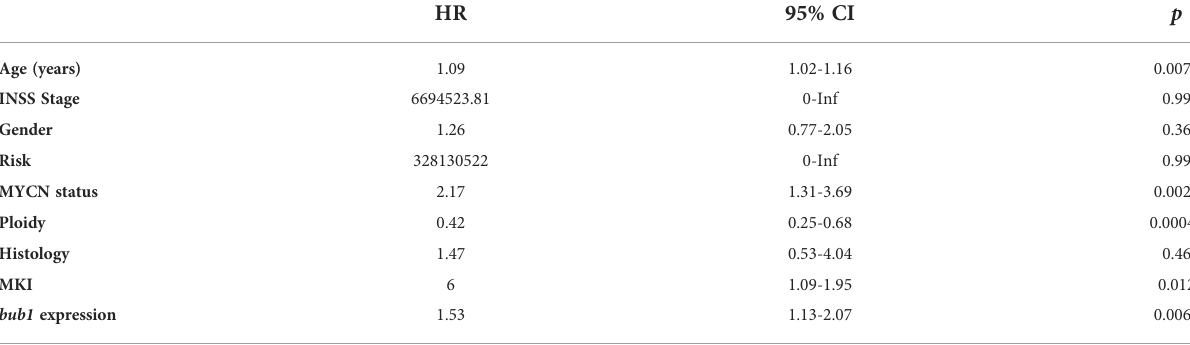
TABLE 3 Univariate Cox analysis of potential risk factors for poor survival of neuroblastoma patients. HR 95% CI